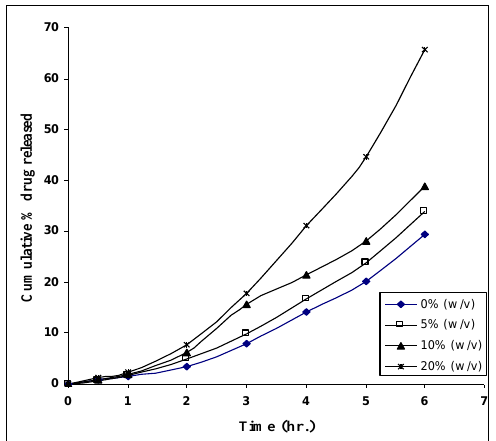
Figure (7): Effect of sorbitol concentration on the release of naproxen from 2.0% (w/v) pectin gels loaded with 2.5% (w/v)